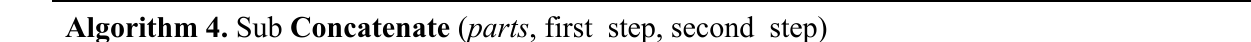
Algorithm 4. Sub Concatenate ( parts , first_step,